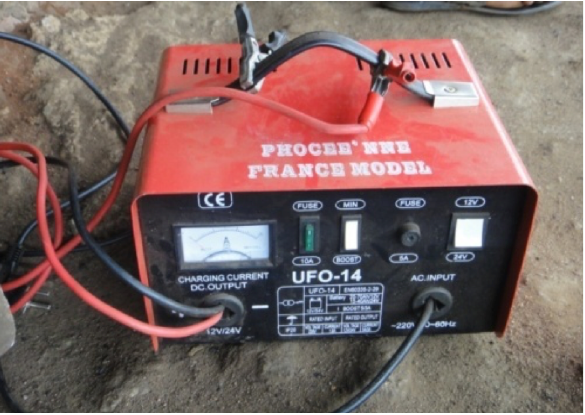
Figure 2 | Electric Battery charger. Photograph by Kingsley O. Emeriewen, 2009.